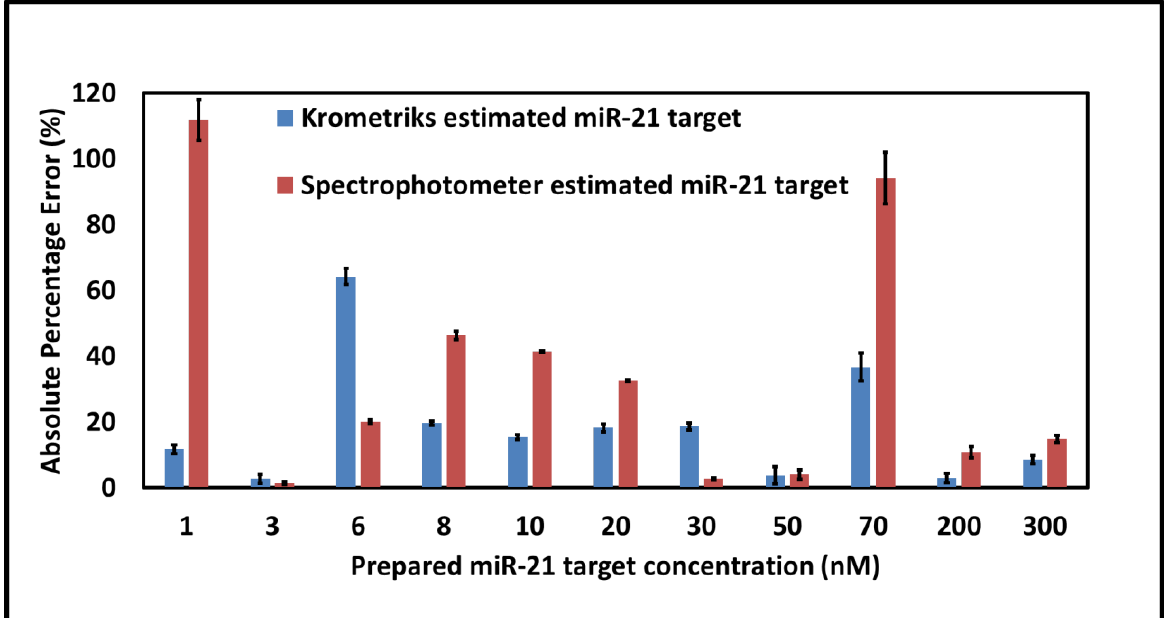
Figure 5. Bar plot showing the absolute percentage errors for the estimated concentration values obtained by the Krometriks app (blue) and the spectrophotometer (red) for different miR-21 target concentrations. The error bars indicate one standard deviation of variation in the measurement values.